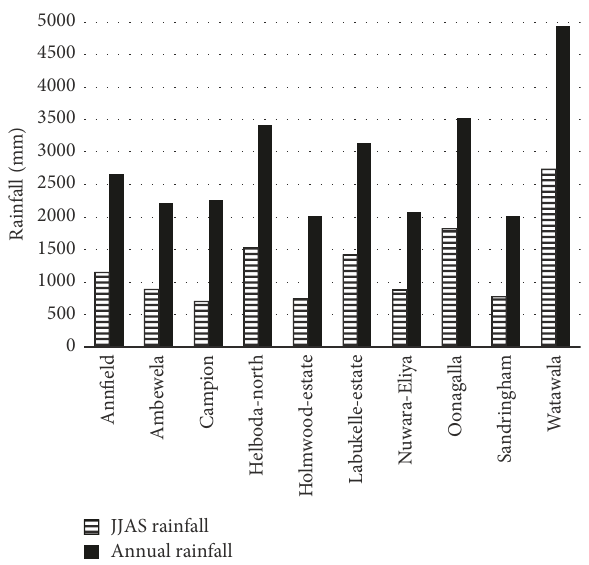
Figure 2: Contribution of rainfall during JJAS season to annual rainfall for the stations.